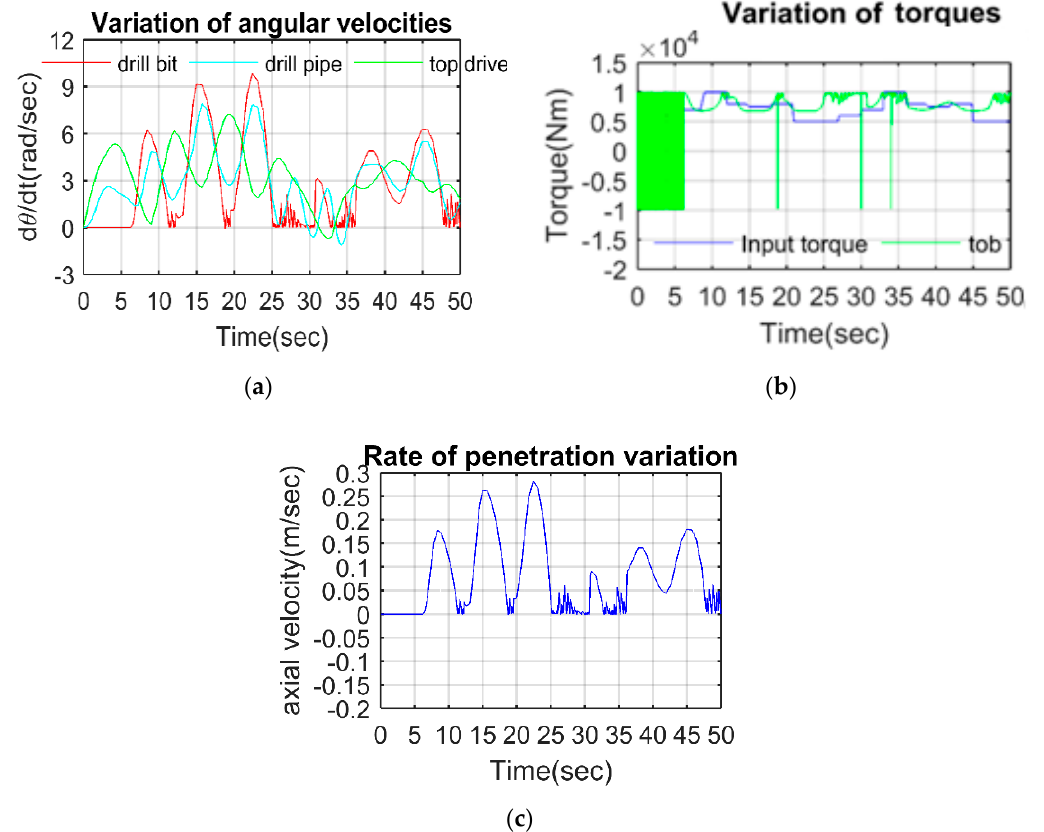
Figure 11. Results of system responses for fourth scenario: ( a ) angular velocities, ( b ) Tob, ( c ) ROP.